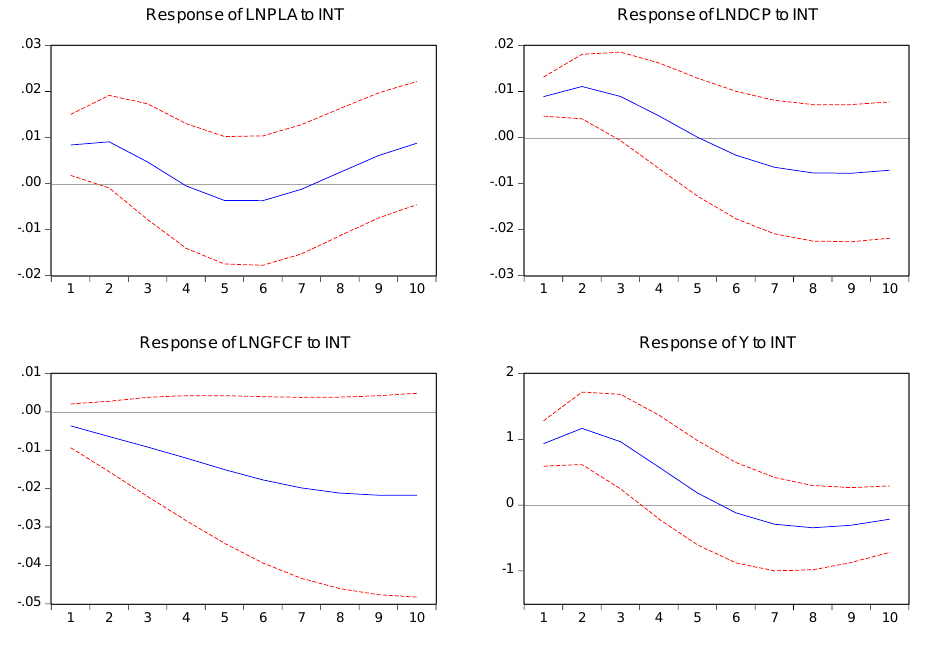
FIGURE 2: Impulse responses to an interest rate shock PLA: Potential Liquidity Available; INT: Real Interest Rate; DCP: Domestic Credit to Private Sector; GFCF: Gross Fixed Capital Formation; Y: GDP growth Impulse responses of the selected variables to a shock on domestic credit to the private sector are presented in FIGURE 3. The figure shows that following the shock, real output growth increases significantly to a maximum of 15% above the baseline in the second quarter, and thereafter declines to equilibrium in the fourth quarter. Interest rates also respond to the shock with an increase of 1.5% initially and 2% above the baseline in the second quarter before declining to equilibrium. This shows that an increase in domestic credit to the private sector raises interest rates probably due to a declining ability of the financial intermediaries to convert other assets into loans and